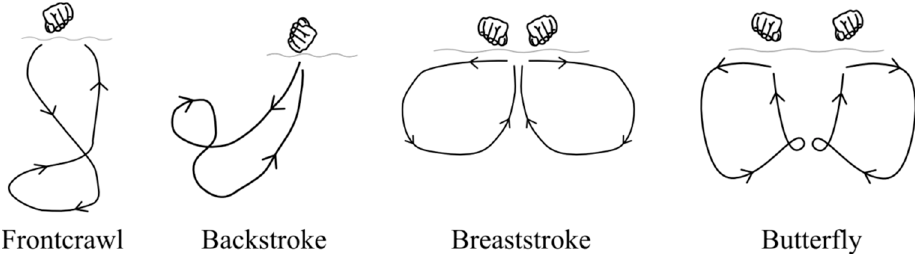
Figure 1. Representation of typical arm actions during swimming, highlighting the characteristic patterns of movement and sweeps of the arms for each of the four competitive strokes. Adapted from Maglischo [1].